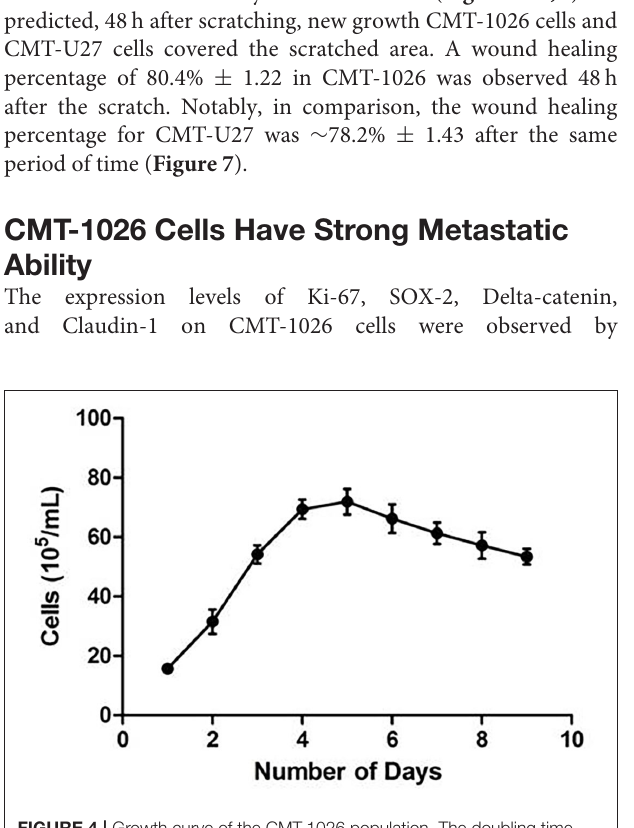
FIGURE 4 | Growth curve of the CMT-1026 population. The doubling time was calculated to be 23.95h.